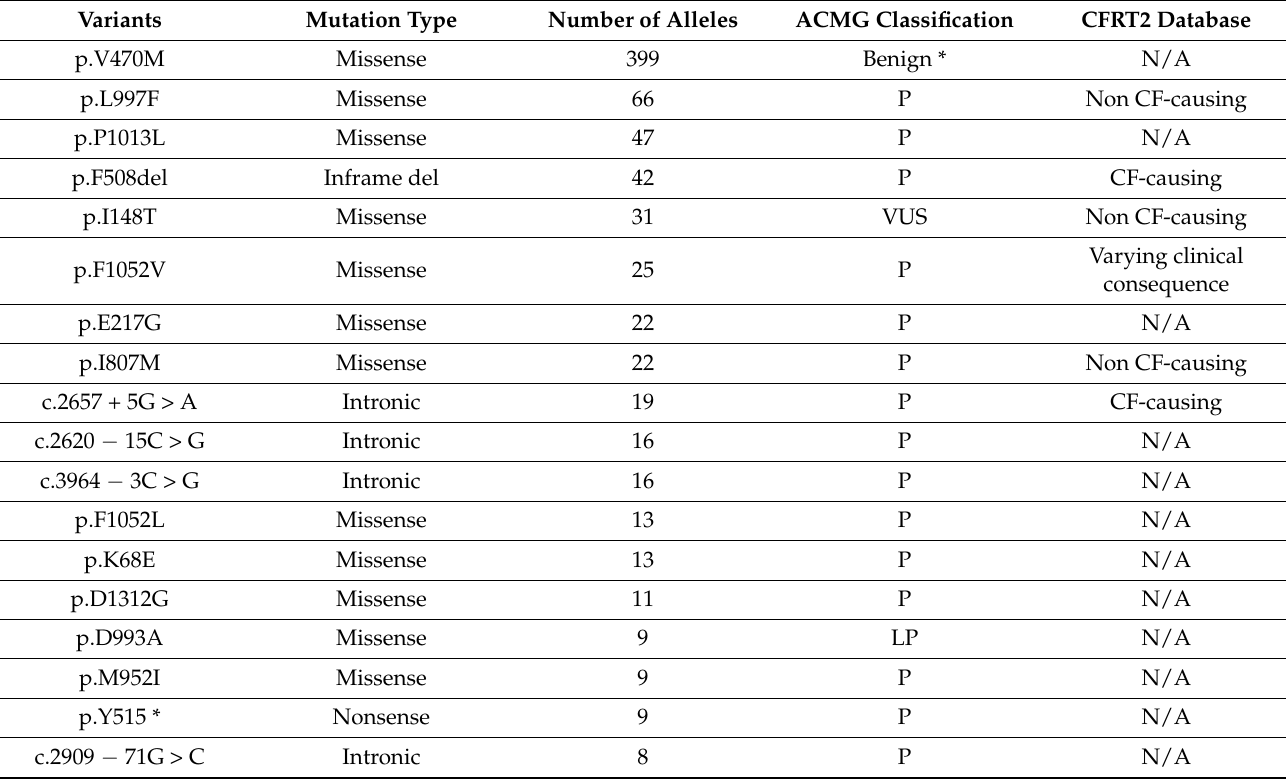
Table 2. The total list of mutations detected. * Not expected to have a major effect on the disease but have a cumulative effect with other pathogenic